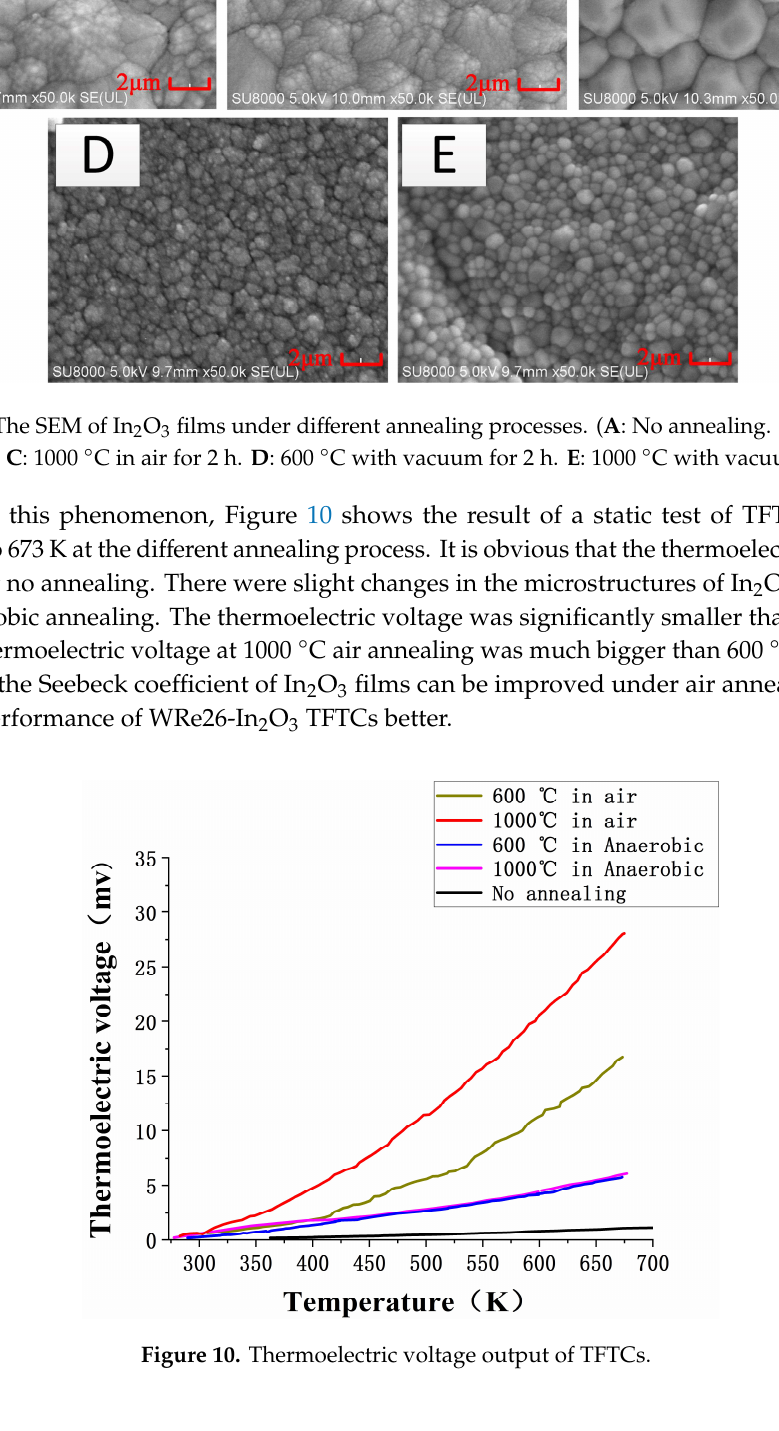
Figure 10. Thermoelectric voltage output of TFTCs.